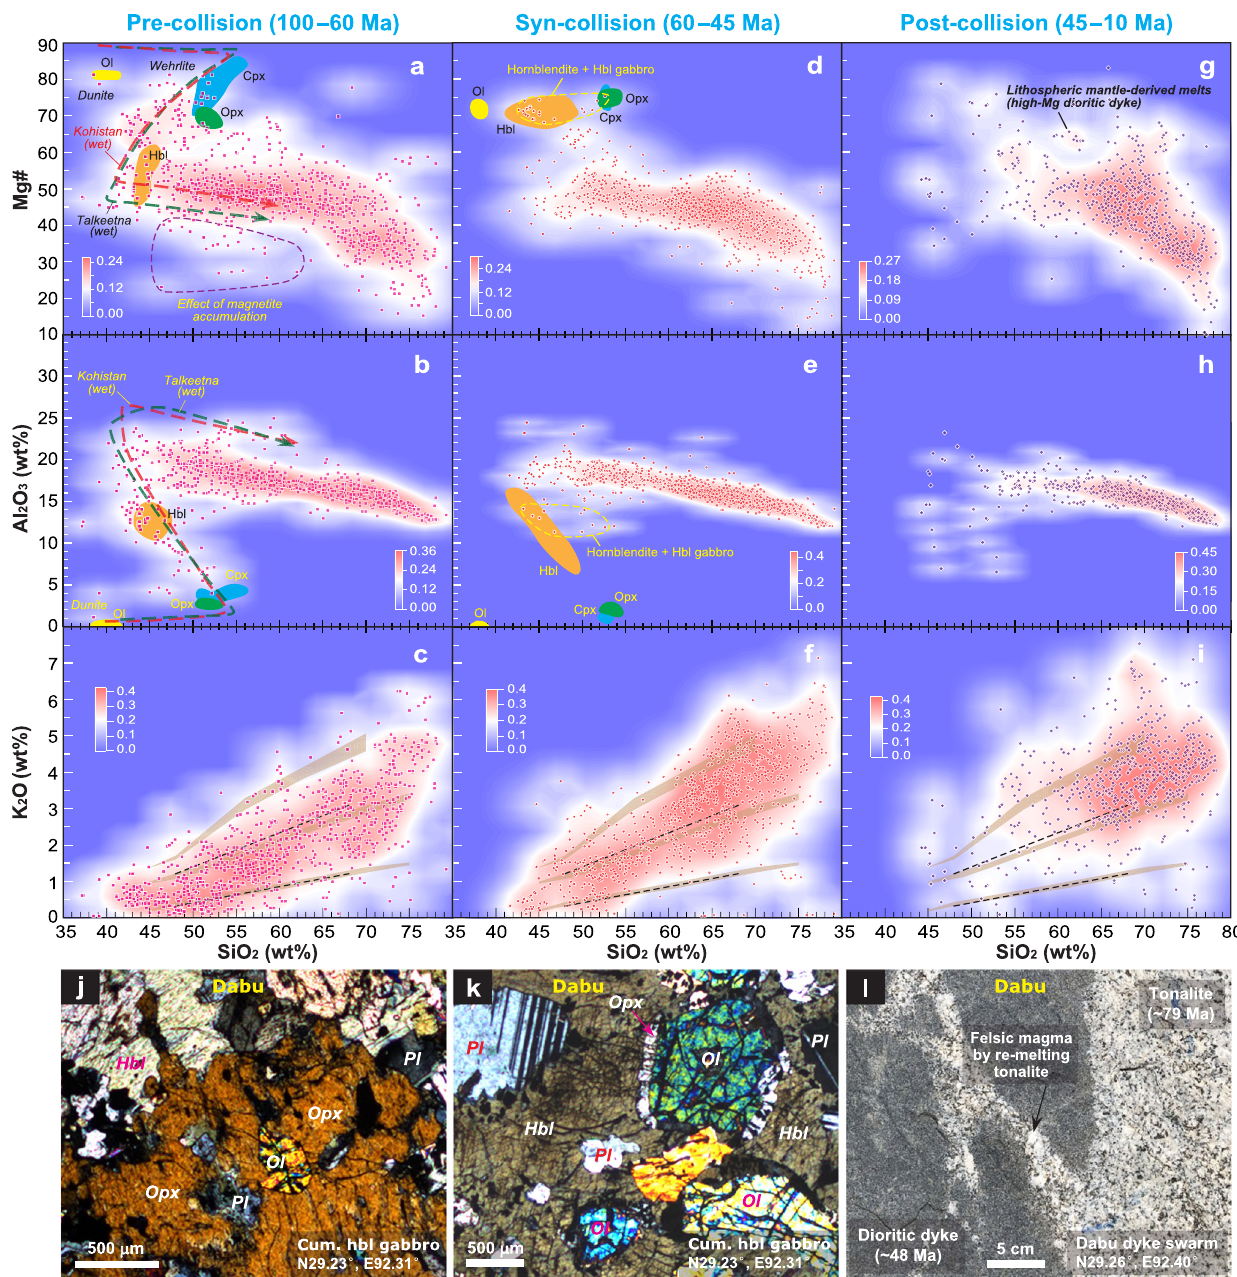
Fig. 2 | Whole-rock Mg#, Al 2 O 3 , and K 2 O vs. SiO 2 plots and photomicrographs of samples from the Gangdese Batholith. a – c Plots of pre-collisional samples (100 – 60Ma). Ma fi c and ultrama fi c samples de fi ne a Z-shaped trend in a and an S-shaped trend in b , similar to Kohistan (dashed red line) and Talkeetna (dashed green line) trends 19,20 . d – f Plots of syn-collisional samples (60 – 45Ma). g – i Plots of post-collisionalsamples(45 – 10Ma).Coloredbackgroundindicatessampledensity distribution as measured by bivariate kernel density, where red background cor- respondstoincreasedsampleconcentrationordensity.ThesameistrueforFig.3. Comparison between c , f , and i shows the temporal evolution of the magmatic rocks towards higher silica and higher potassium contents, accompanied by the loss of samples with SiO 2 <55wt%. Photomicrographs of a syn-collisional, ~50Ma